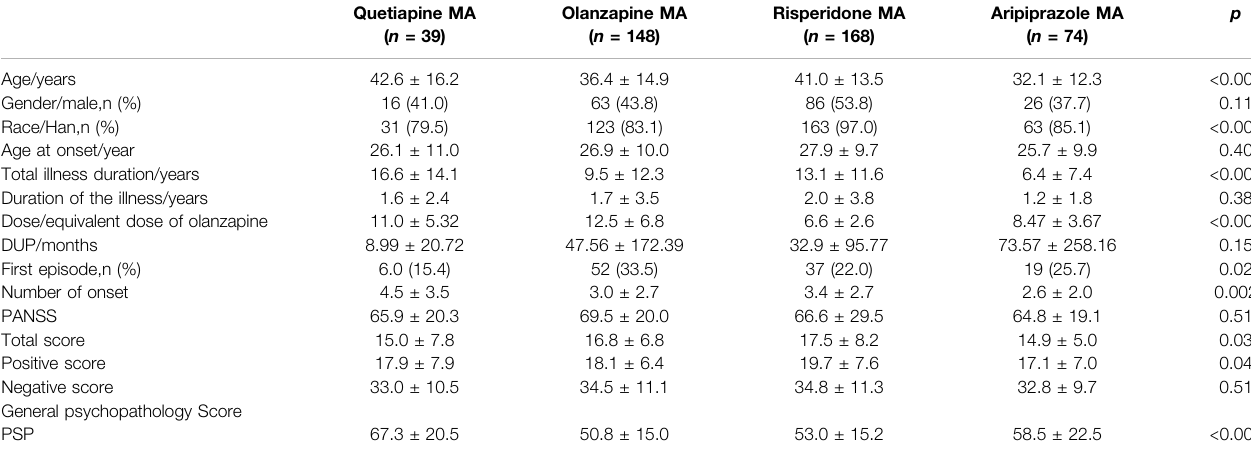
TABLE 1 | Demographic and clinical characteristics of the study population (MA).